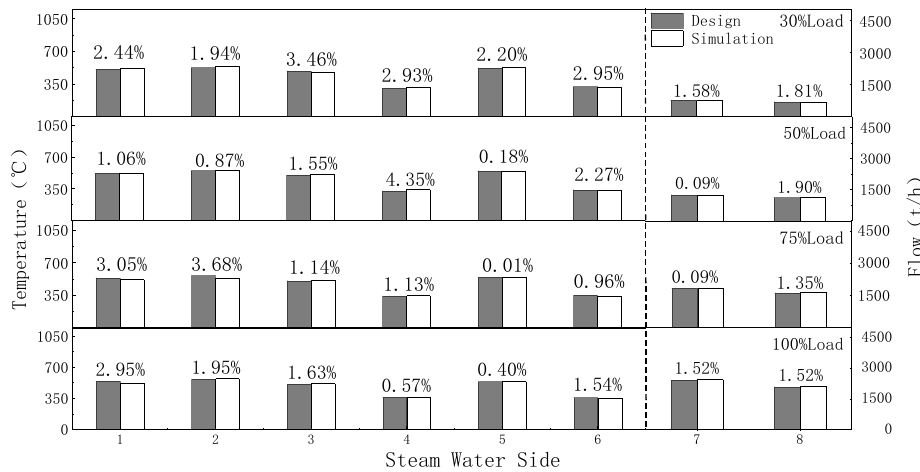
Figure 2. Simulation error histogram of steam water side.